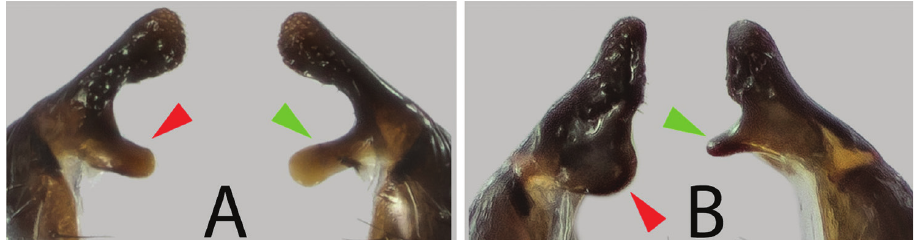
Figure 1. Surstyli (dorsal view) for male Themira biloba ( A ) and Themira “ biloba- like” ( B ). Red arrows indicate basal process on left surstylus; green arrow for basal process on right